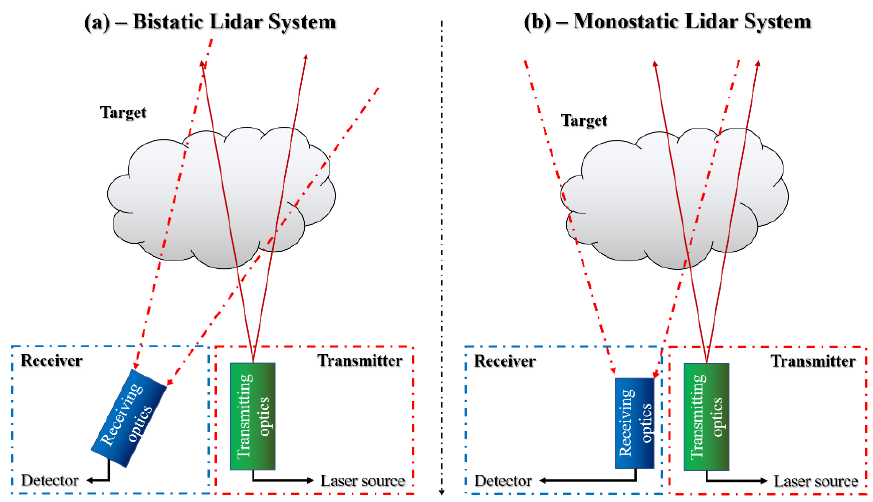
Figure 3. Bistatic ( a ) and monostatic ( b ) Lidar configurations.